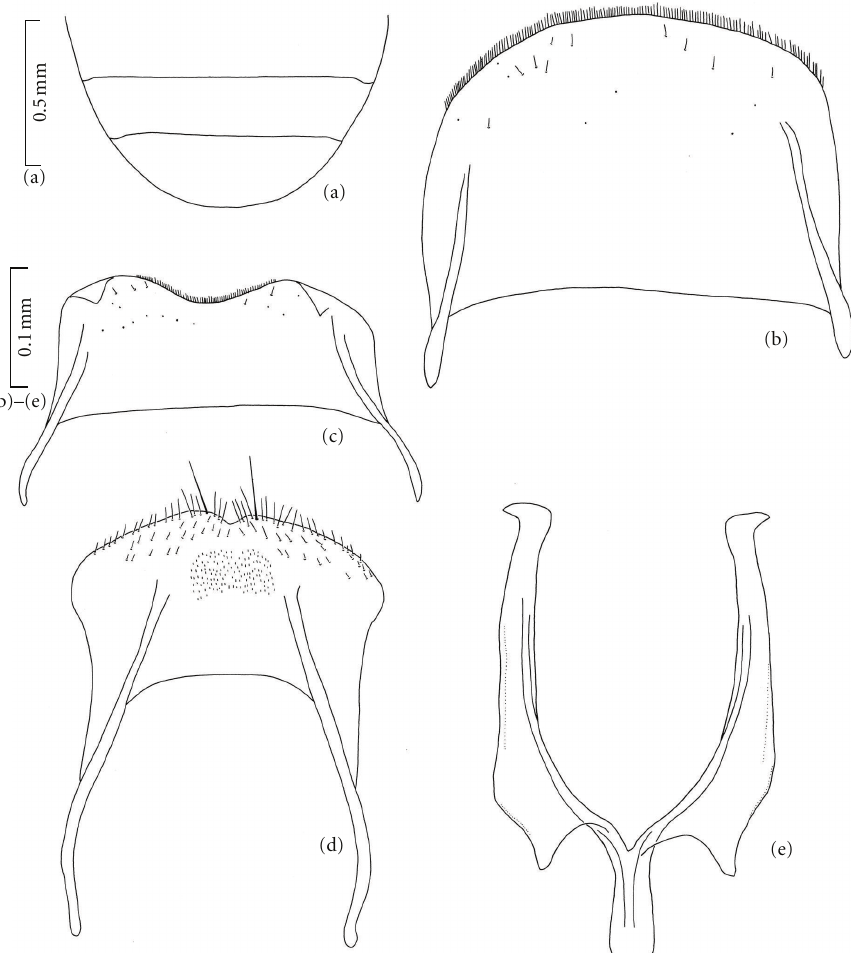
Figure 8: Hydrocyphon doiinthanonensis sp.n., holotype, male. (a) Sternites V–VII; (b) tergite VIII; (c) tergite IX; (d) sternite IX; (e) tegmen.